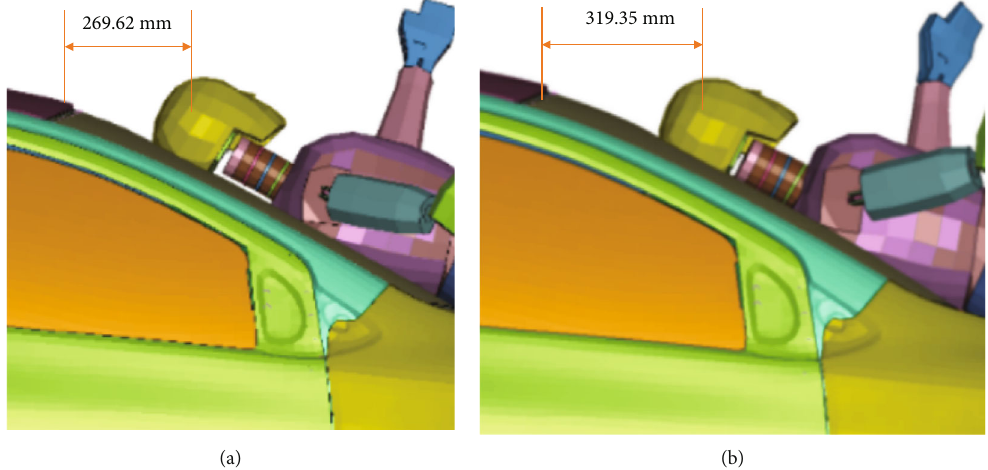
Figure 11: Cyclist ’ s head windshield contact at the vehicle. (a) No passive safety device (b) with a passive safety device.